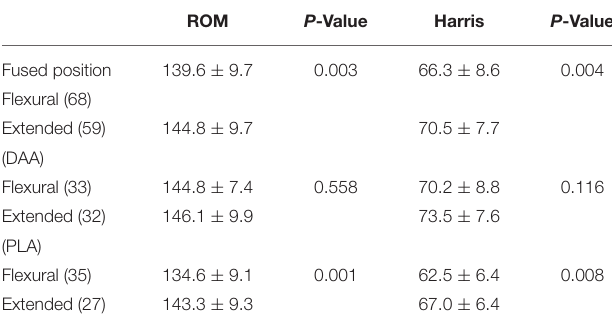
TABLE 4 | Harris scores and ROM of patients of two groups for 1-month